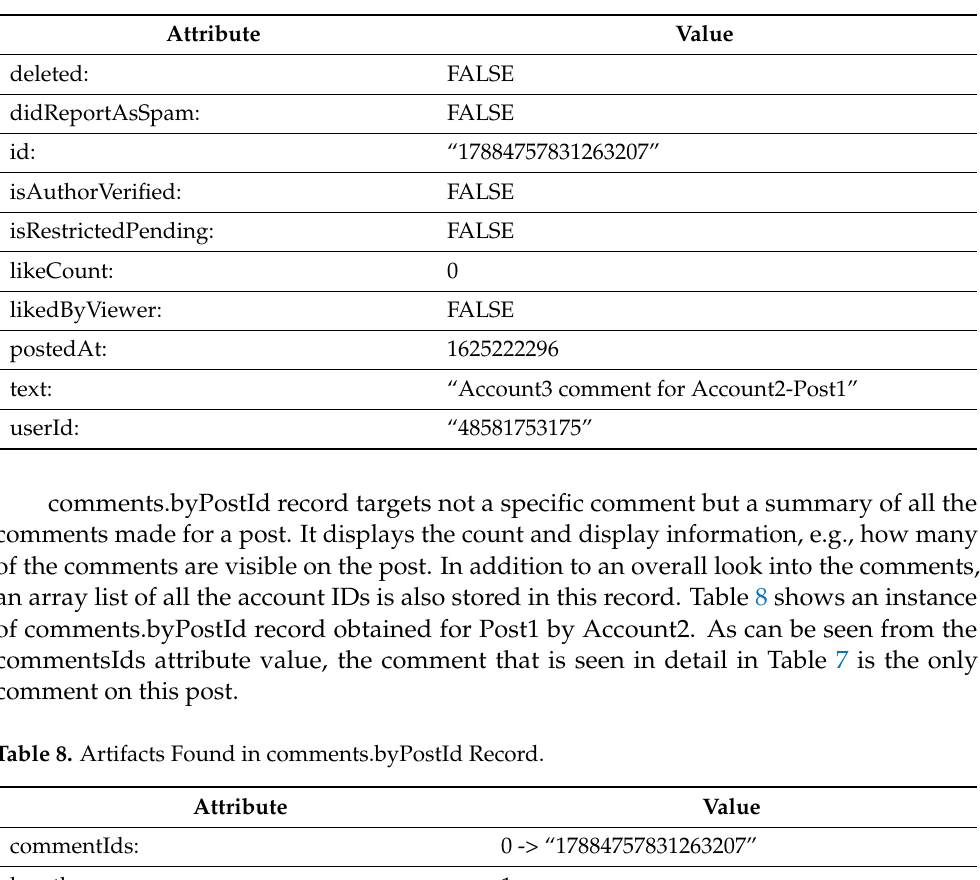
Table 7. Artifacts Found in comments.byId Record.